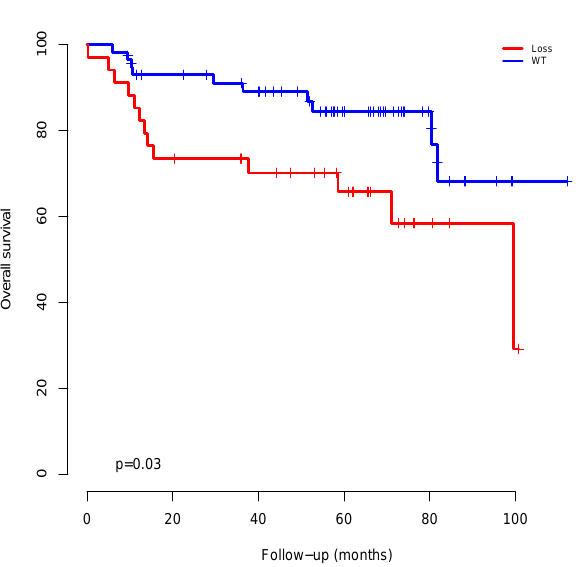
Figure 3. Overall survival of chromosome 14 q 22.1 which encompasses the NIN gene.